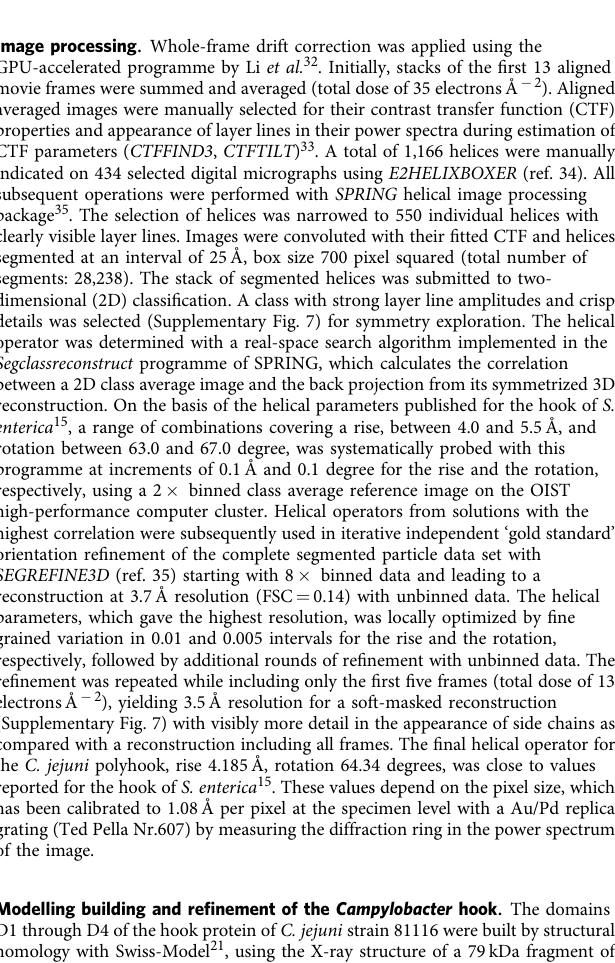
Figure 7 | Motility and flagella of C. jejuni expressing FlgE with domains D3 and D4 deleted. ( a ) Motility phenotype of C. jejuni strains stab inoculated into motility agar after 32h at 37 (cid:2) C. The following strains were examined: the wild-type strain; the D flgE ::Km R mutant strain; the D flgE ::Km R þ FlgE mutant strain; and the D flgE ::Km R þ FlgE( D [D3–D4]) mutant strain, which encodes FlgE deleted for the D3 and D4 domains. ( b ) Motility phenotype of the D flgE ::Km R þ FlgE( D [D3–D4]) strain and ( c ) the D flgE ::Km R strain inoculated into motility agar both after 56h at 37 (cid:2) C. The wild-type strain and the D flgE ::Km R þ FlgE mutant strain covered the plate after 56h at 37 (cid:2) C and are not shown. ( d ) Negatively-stained wild-type cells examined by transmission electron microscopy with bipolar flagella. ( e ) Cells of the D flgE ::Km R strain without flagella. ( f ) Cells of the D flgE ::Km R þ FlgE strain with bipolar flagella. ( g ) Cells of the D flgE ::Km R þ FlgE( D [D3–D4]) strain with one long flagellum or short flagellar stubs at the cell poles. At least 30 cells were examined for each strain and representative cells are shown. Scale bars, 1 m